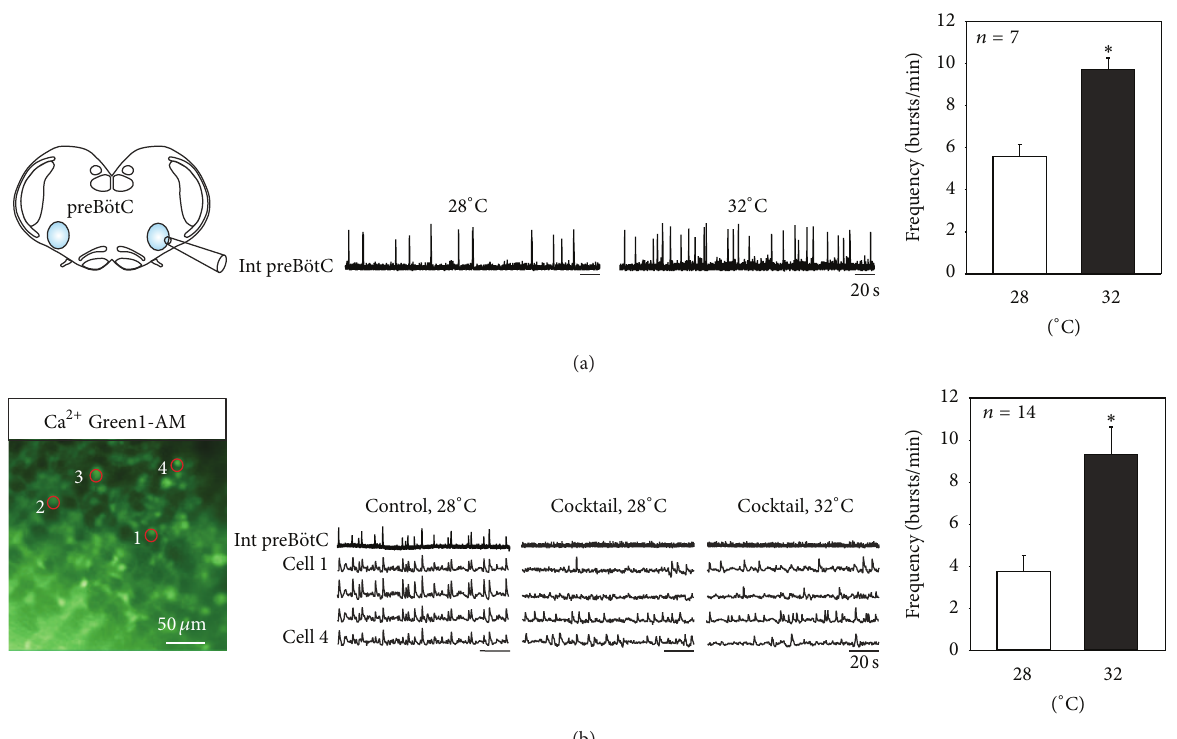
Figure 6: The embryonic respiratory network and respiratory pacemaker neurons respond to temperature changes. (a) Left: schematic of an embryonic transverse slice used for extracellular electrode recording from the isolated preB¨otC network. Middle: integrated traces of spontaneous network activity recorded at 28 ∘ C (left) and at 32 ∘ C (right). Right: pooled data showing mean inspiratory burst frequency ( ± SEM) in 7 slices in control conditions at 28 ∘ C (white bar) and at 32 ∘ C (black bar). Asterisk: 𝑃 < 0.05 . (b) Left: fluorescent image showing location of 4 preB¨otC network neurons monitored with calcium imaging. Middle: simultaneous recordings of network electrophysiological activity (Int preB¨otC) and calcium transients in the 4 individual cells in control conditions at 28 ∘ C (left), after synaptic isolation in cocktail at 28 ∘ C (middle), and in cocktail at 32 ∘ C (right). Note that the frequency of spontaneous cyclic activity in isolated cells 1 and 3 increased at 32 ∘ C, while that of cell 4 decreased and cell 2 only became active at the elevated temperature. Right: pooled data showing mean frequency ( ± SEM) of activity expressed by 14 pacemaker neurons under cocktail at 28 ∘ C (white bar) and in cocktail at 32 ∘ C (black bar). Asterisk: 𝑃 < 0.05